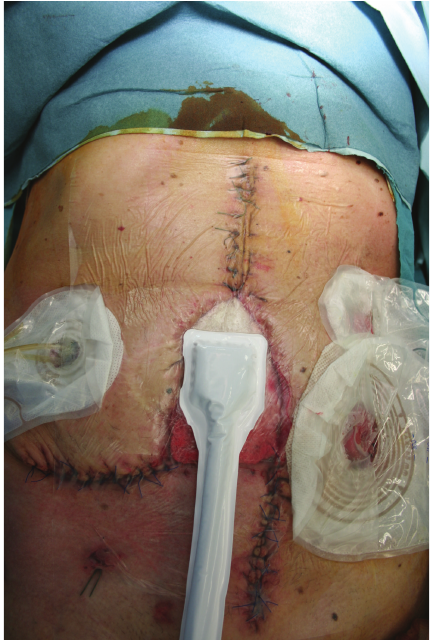
Figure 2: NPWT applied over the biological mesh.